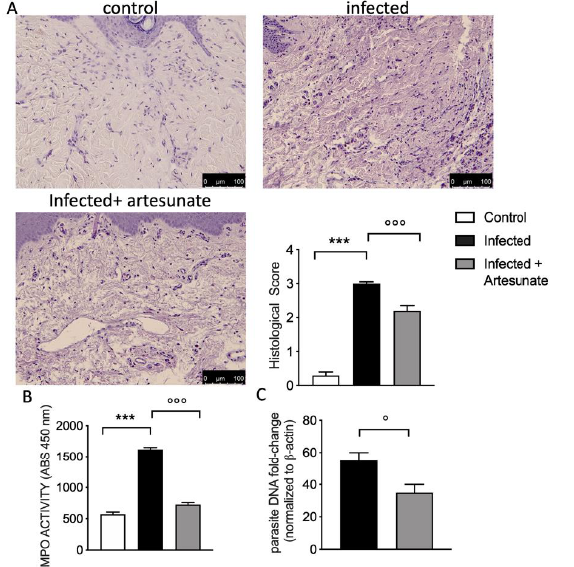
compared to infected group. Data are expressed as mean ± SEM from N = 10 mice for each group. *** p < 0.001 vs. control group; ** p < 0.01 vs. control group; °° p < 0.01 vs. infected group; ° p < 0.05 vs. infected